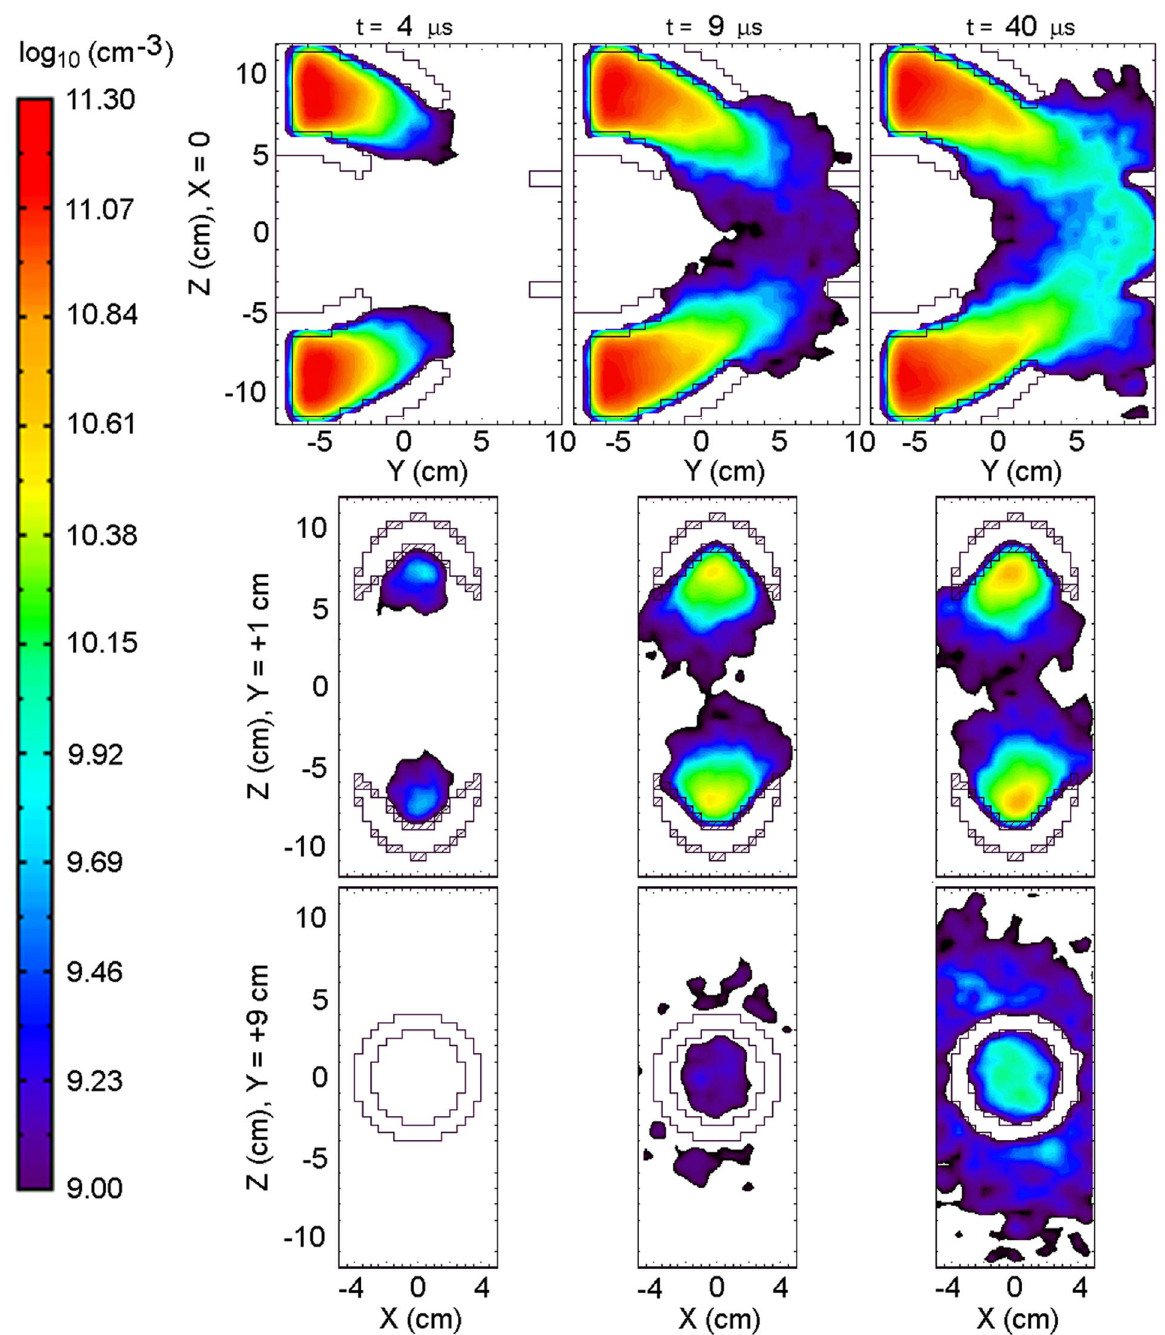
FIG. 5. (Color) FCAPS plasma density n isocontours at t (cid:6) 4 (cid:1) s (left column), t (cid:6) 9 (cid:1) s (center column), and t (cid:6) 40 (cid:1) s (right p column) as f y; z g slices at x (cid:6) 0 (first row), f x; z g slices at y (cid:6) (cid:7) 1 cm (second row), and f x; z g slices at y (cid:6) (cid:7) 9 cm (third row). All plots are on the same log 10